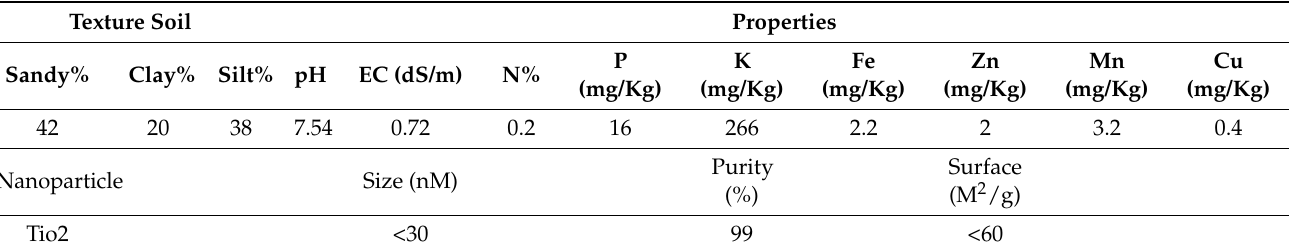
Table 2. Some physical and chemical characteristics of titanium dioxide nanoparticles and soil used in the experiment